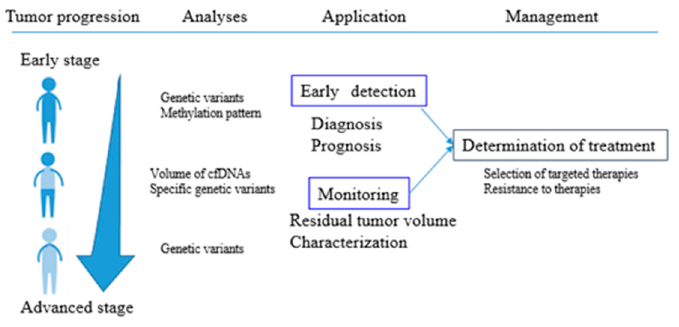
Figure 2. ctDNAs as promising biomarkers in the different phases of cancer progression. The schematic summarizes the most suitable clinical applications in each phase. In early stage, genetic variants and methylation patterns of ctDNAs might be useful for early diagnosis. Relevant